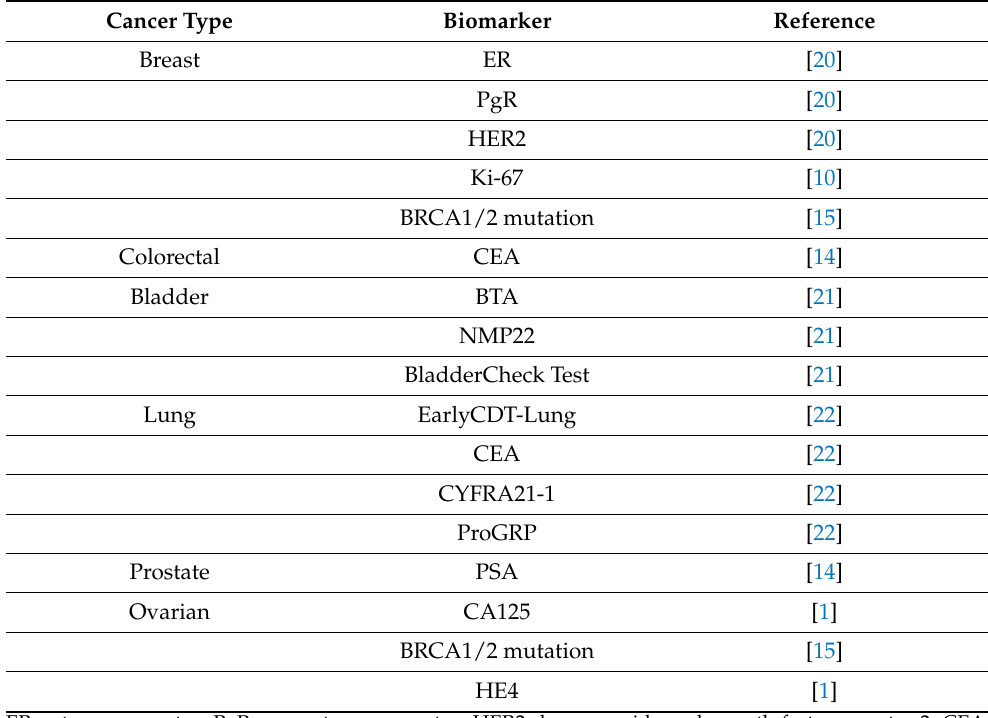
Table 1. Clinically established cancer